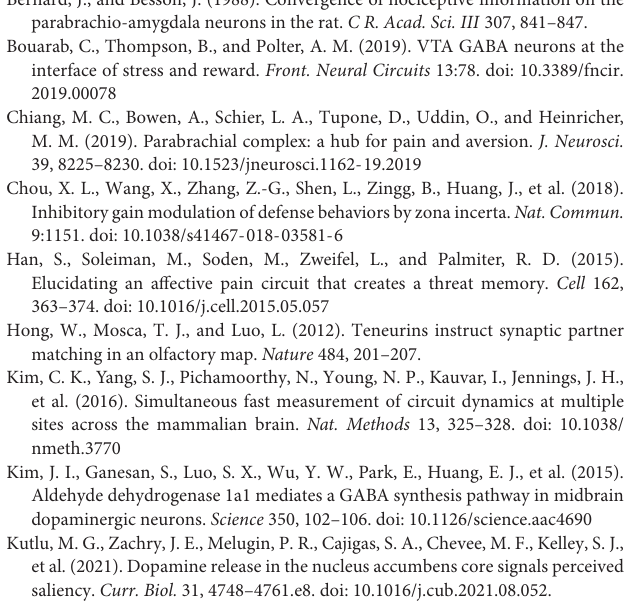
Supplementary Figure 1 | VTA DA outputs without the four targeted projection sites. (A) Cumulative explained variance from each principal component. (B) Samples are plotted in PCA space for the 1st and 2nd components, colored by projection. (C) Samples are plotted in PCA space for the 1st and 3rd components, colored by projection. (D) Heatmap of each output region’s contribution to the first three principal components. (E) Brains are plotted in UMAP space, colored by projection. (F) Output regions are plotted in UMAP space, embedded with respect to z-scores across mouse brains. Clusters represent outputs with similar patterns of variation across the cohort. Supplementary Figure 2 | VTA input dimensional reduction without non-Cre and projection-undefined conditions. (A) Brains are plotted in PCA space for the 1st and 2nd components, colored by cell type. (B) Brains are plotted in PCA space for the 1st and 2nd components, colored by projection. (C) Brains are plotted in UMAP space, colored by cell type. (D) Brains are plotted in UMAP space, colored by projection. Supplementary Figure 3 | Input and output z-scores stitched together for all cell types. (A) Z-scores of average input and output counts for each projection condition. Inputs are marked with a green down arrow and outputs with a red up arrow. Regions are sorted according to the projection in which they receive the highest rank. Supplementary Figure 4 | Revealing RABV input PCs and starter cell locations that predict projection conditions. (A) Logistic regression coefficients for five principal components. Positive coefficients predict this condition when the feature is higher. Negative coefficients predict this condition when the feature is lower. Model scores are provided in Table 3 . (B) Logistic regression coefficients for starter cell location. (C) Logistic regression coefficients for five principal components and starter cell location. Supplementary Figure 5 | Projection portraits for all inputs from the Allen Brain Connectivity Atlas. All regions are in the same order as index from Figure 4C